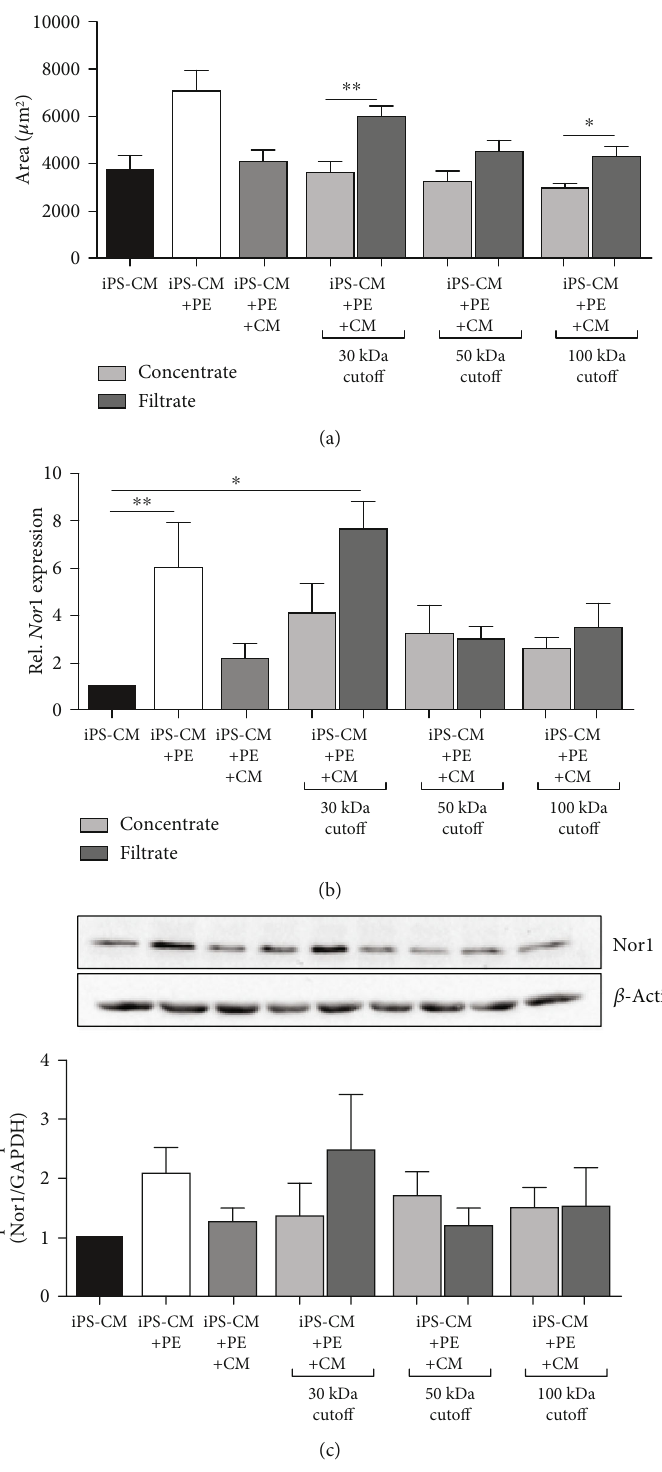
Figure 5: Hypertrophy regression in iPS-CM is mediated by soluble factors larger than 30kDa. Culture supernatant from preconditioned MSCs was fractionated by ultra fi ltration using columns with 30 kDa, 50kDa, and 100kDa cuto ff . Hypertrophied iPS-CM were treated with the di ff erent concentrates and the corresponding fi ltrates for 24h. MSC-conditioned medium (CM) was used as a control. (a) Quanti fi cation of the cell surface area by immuno fl uorescence. n = 10 . Nor1 gene (b) and protein (c) expression was quanti fi ed in iPS-CM. n = 5 . ∗ p < 0 : 05 , ∗∗ p < 0 : 01